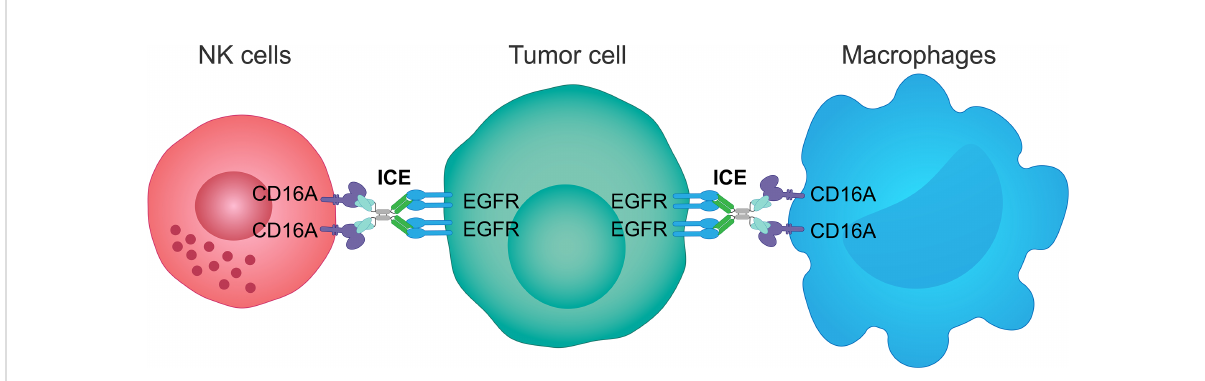
FIGURE 3 Mechanism of action of an innate cell engager targeting EGFR and CD16A. AFM24, a fully human tetravalent bispeci fi c innate cell engager, binds simultaneously the CD16A receptor on NK cells or macrophages, with a much higher af fi nity than monoclonal antibodies, and the EGFR antigen on the surface of tumor cells. This creates a bridge between innate immune cells and EGFR-expressing tumor cells enabling ADCC mediated by NK cells and ADCP mediated by macrophages. ADCC, antibody-dependent cellular cytotoxicity; ADCP, antibody-dependent cellular